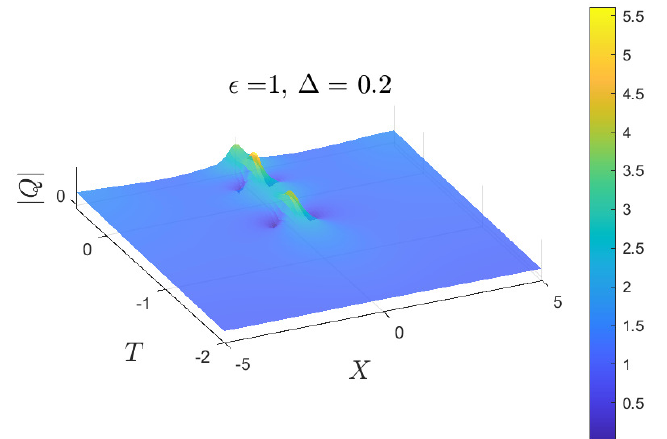
Figure 2. Case 1: Surface plot of the forced Peregrine breather when (cid:101) = 1.0, M = 1, ∆ = 0.2 with the initial condition (10) at T 0 = −